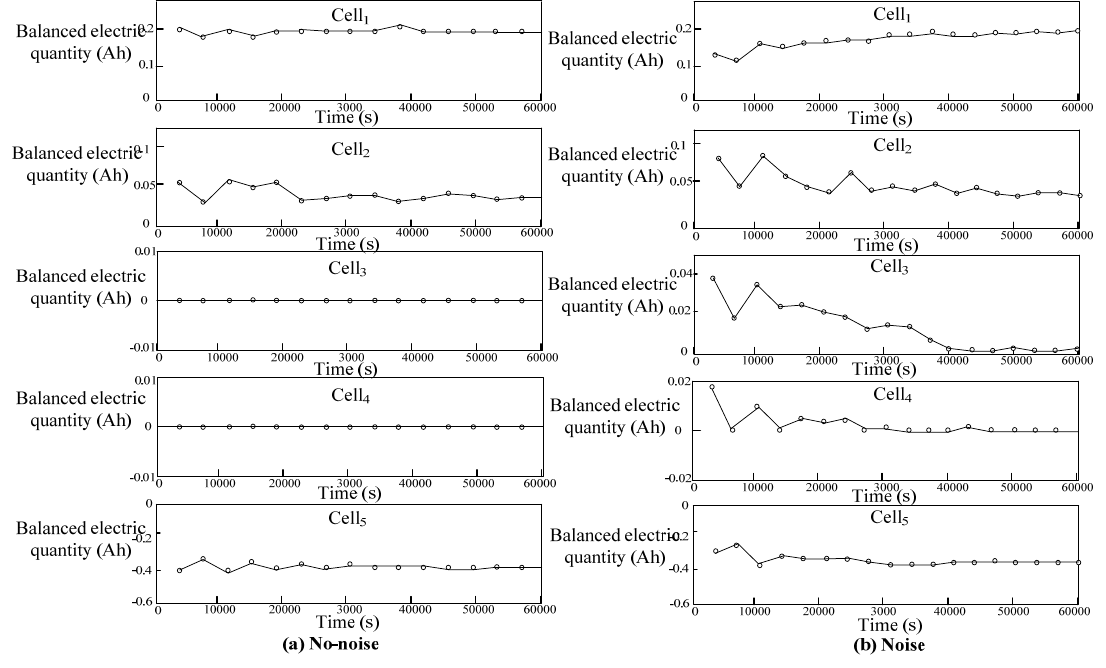
Figure 7. The summary information in conditions of ( a ) no-noise; ( b )